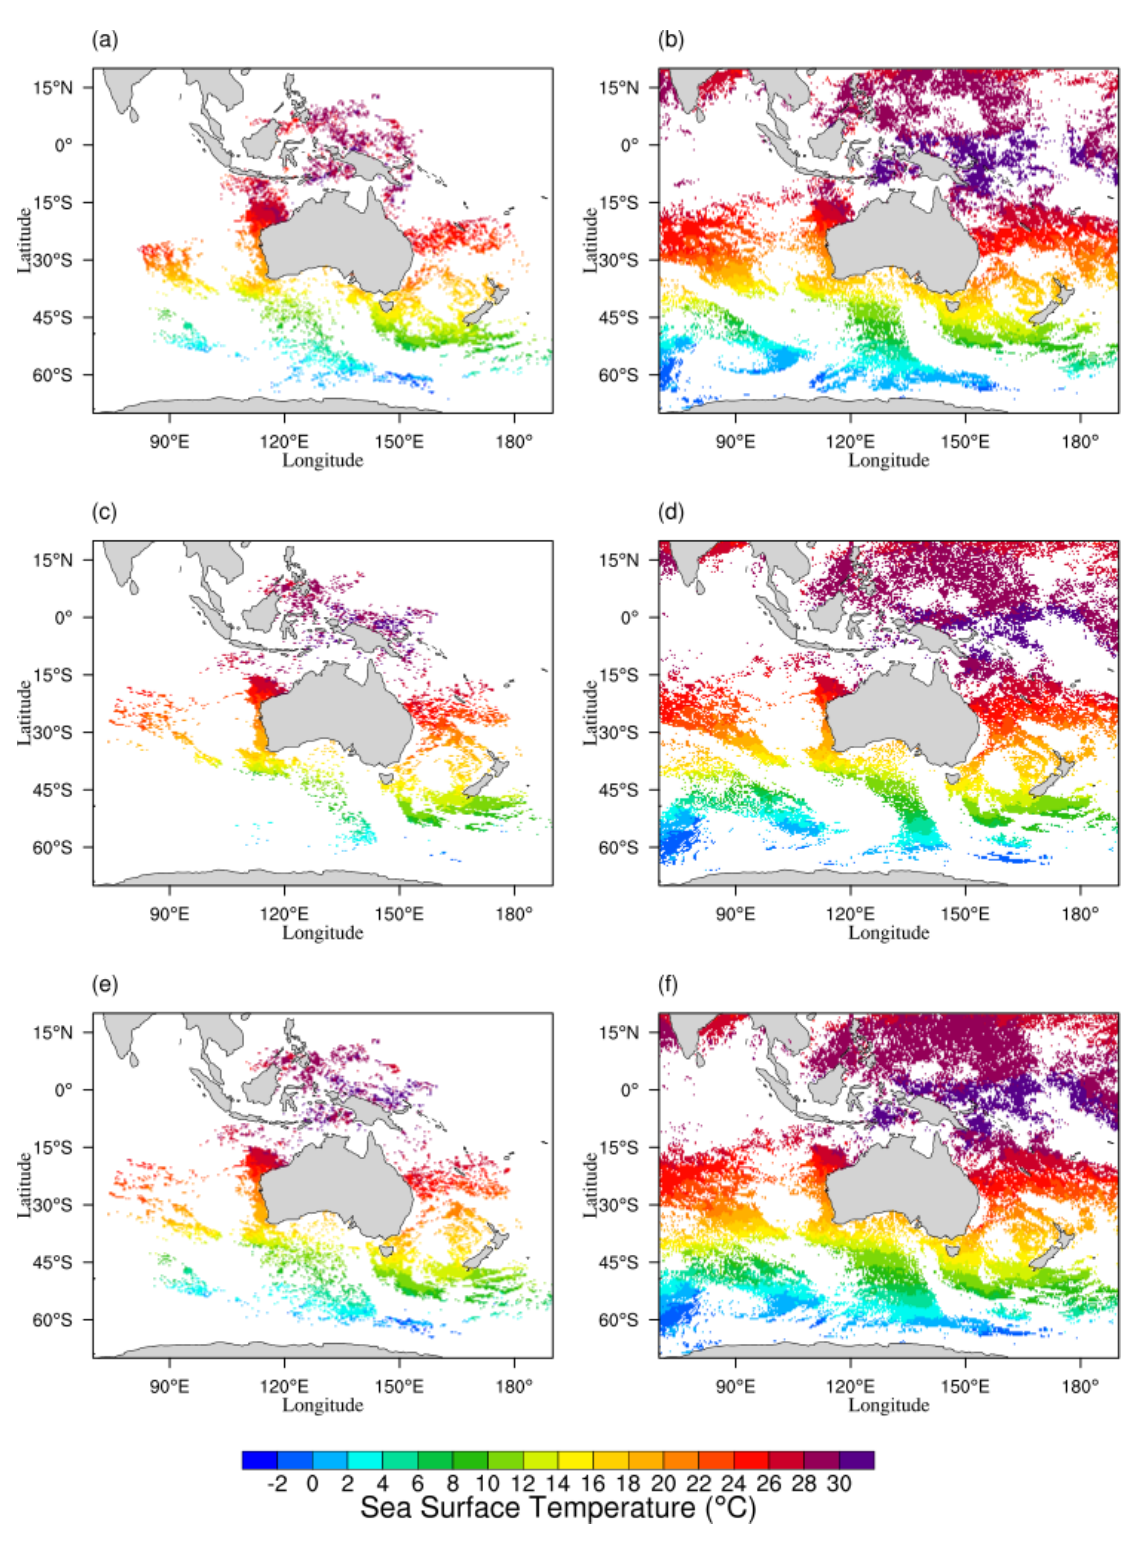
Figure 5. Sea surface temperatures for fv02 L3S–1day from AVHRR-only (NOAA-18) ( a ) day, ( c ) night and ( e ) day and night, and Multi–sensor (NOAA–18, MetOp–B, NPP, N20) ( b ) day, ( d ) night and ( f ) day and night for 12 December 2018. The data shown are for QL ≥ 3. Data were accessed from